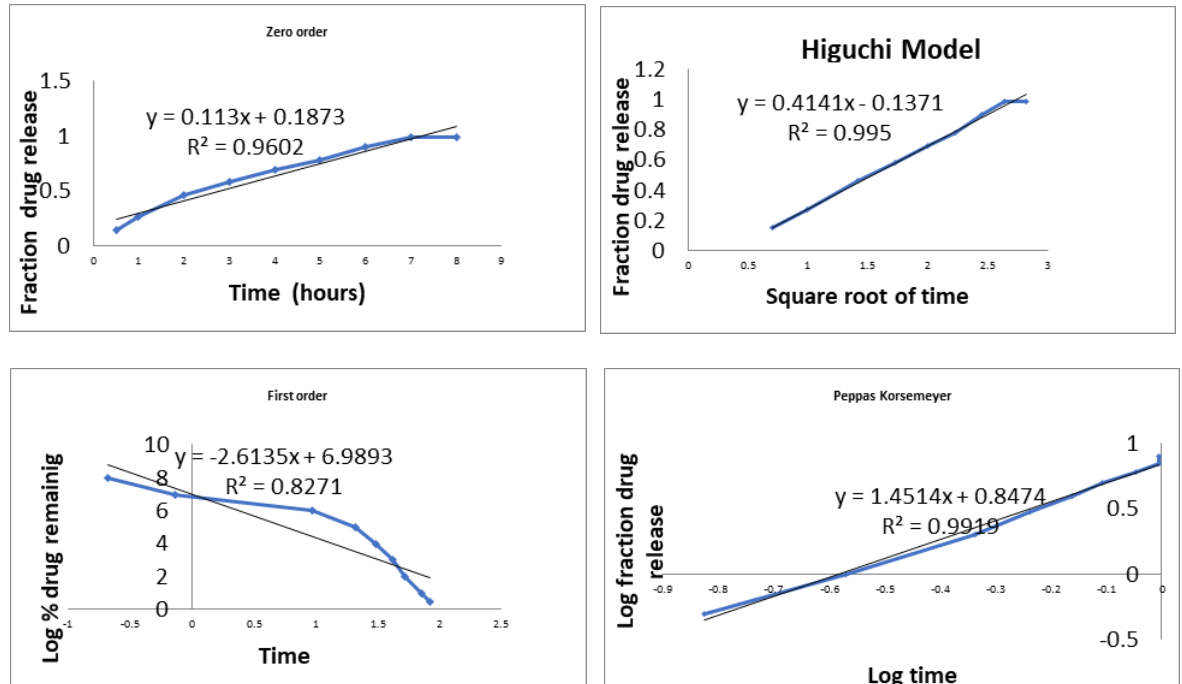
Figure 4. Drug release plot for the developed NSO nanoemulgel showing sustained drug release up to 8 h (n = 3).